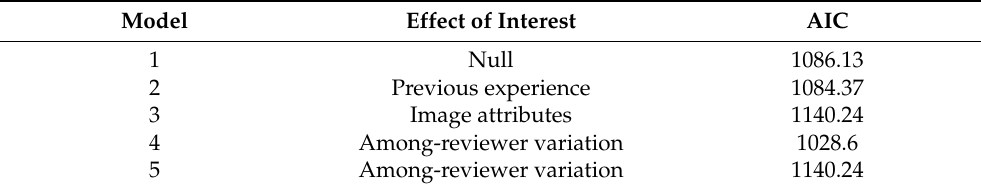
Figure 2. Proportion of correct selections per reviewer. Columns and colours represent the different levels of previous experience in conventional aerial surveys: ( 1 , left ) novice, 1–10 surveys; ( 2 , right ) expert, 10+ surveys. Table 3. Akaike’s information criterion (AIC) values of the general linear mixed models (GLMMS) assessing identification accuracy based on all reviewer answers ( n =